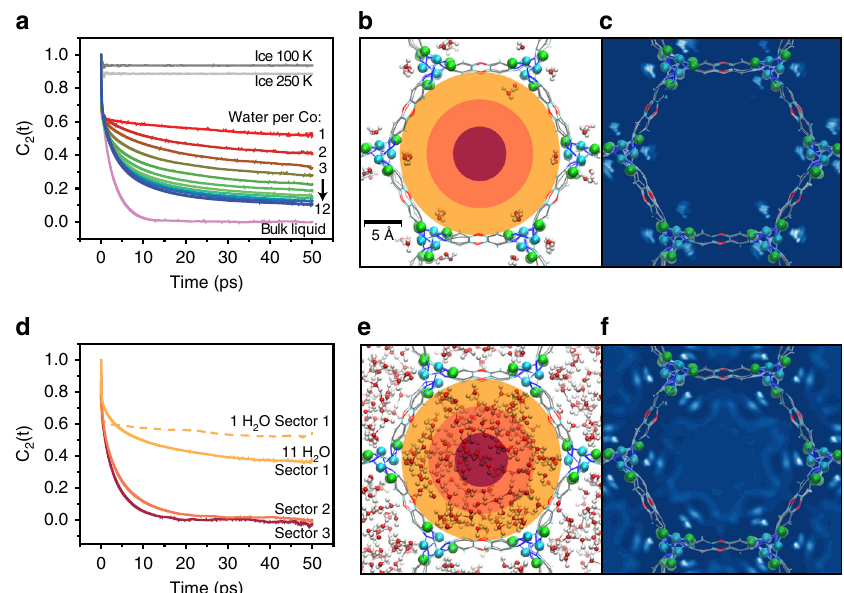
Fig. 5 Dynamics of Water in Co 2 Cl 2 BTDD. a Orientational correlation functions calculated from MB-MD simulations carried out for various loadings of water inside the Co 2 Cl 2 BTDD pores. Also shown for reference are the corresponding orientational correlation functions calculated from MB-MD simulations of liquid water (pink) and ice (gray). b Snapshot from an MB-MD simulation of water in Co 2 Cl 2 BTDD for a loading of 1 H 2 O/Co 2 + . The three concentric colored sectors are de fi ned according to their distance from the pore surface: Sector 1 from 0 – 4 Å (dark yellow), Sector 2 from 4 – 8 Å (orange), and Sector 3 from 8 – 12 Å (red). c Two-dimensional (2-D) density map of water calculated from MB-MD simulations carried out for a loading of 1 H 2 O/Co 2 + (lighter colors correspond to regions with higher water density). d Orientational correlation functions calculated for water in the three different sectors of the pore at either 1 H 2 O/Co 2 + (dashed line) or 11 H 2 O/Co 2 + (solid lines). e Snapshot of an MB-MD simulation of water in Co 2 Cl 2 BTDD for a loading of 11 H 2 O/Co 2 + (the three concentric colored sectors are de fi ned as in b . f 2-D density map for a loading of 11 H 2 O/Co 2 + (lighter colors correspond to regions with higher water density) molecules enter sector 2 at a loading of 2 H 2 O/Co 2 + and start fi lling Table 1 Dynamics of water in Co 2 Cl 2 BTDD sector 3 at a loading of 7 H 2 O/Co 2 + (Fig. 5d and Supplementary Figs. 11, 12). At the loading of 11 H 2 O/Co 2 + , the water molecules fi